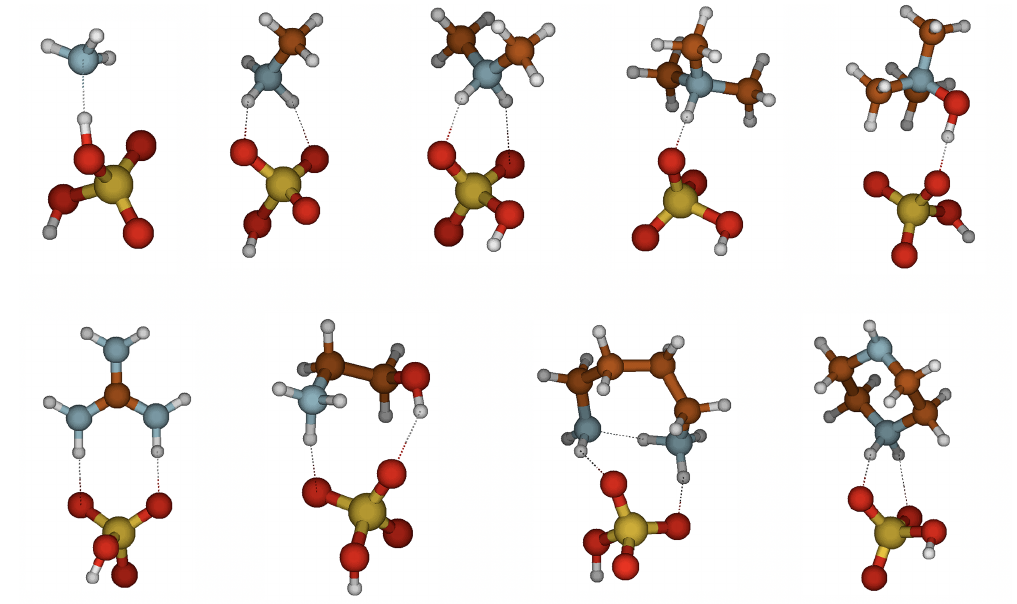
Figure 1. Heterodimers of SA with AMM, MA, DMA, TMA, TMAO, GUA, MEA, PUT and PZ, respectively.